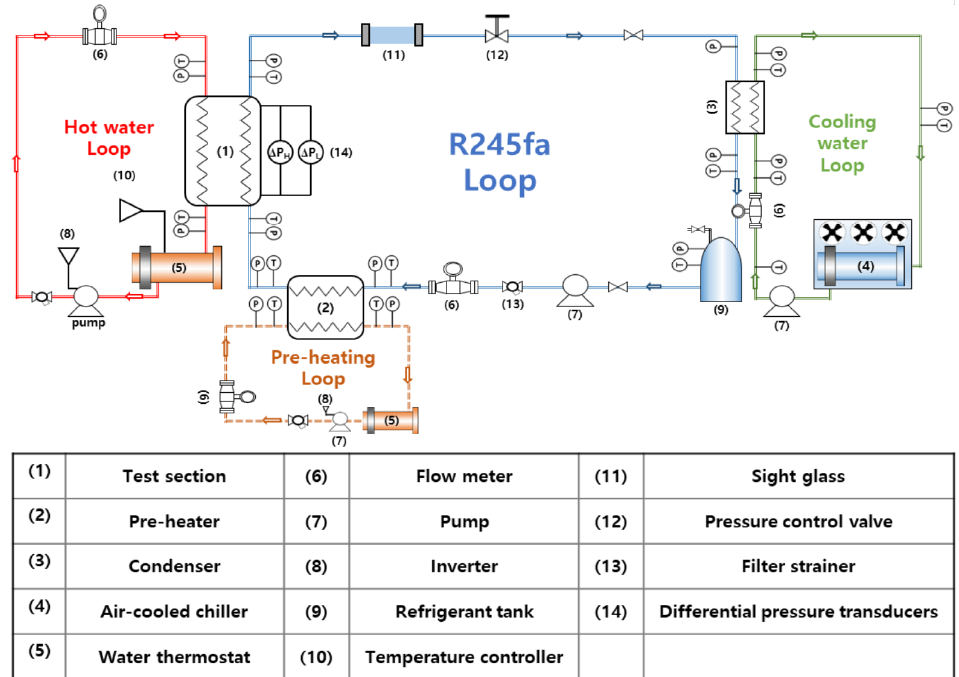
Figure 3. Diagram of the test loop and equipment/sensor positions. Table 3. Experimental conditions.